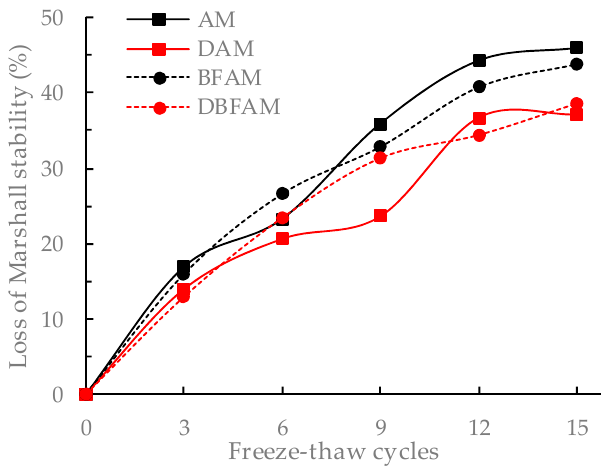
Figure 16. Loss of Marshall stability under F–T cycles.